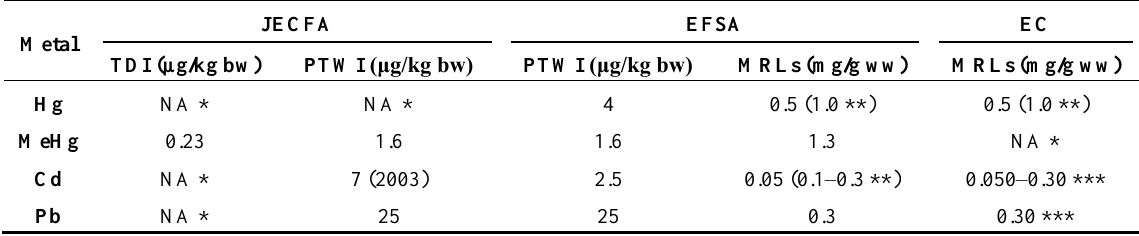
Table 1. Maximum Residue Levels (MRLs) in fish tissue and Intakes (TDI, PTWI) Cd,